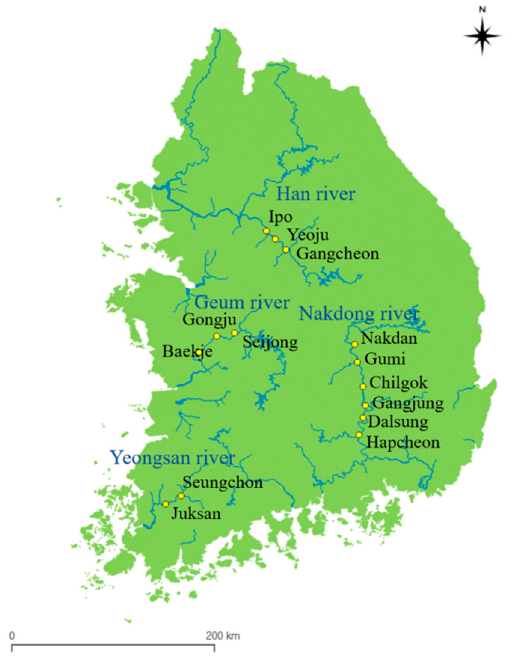
Figure 1. Study site.